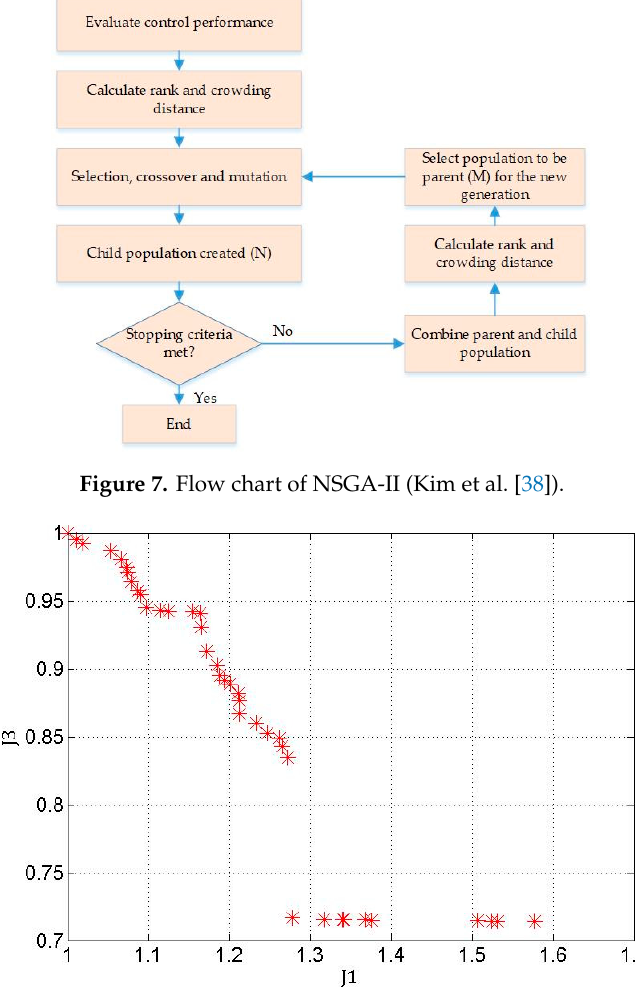
Figure 8. Pareto front of NSGA-II under North Palm